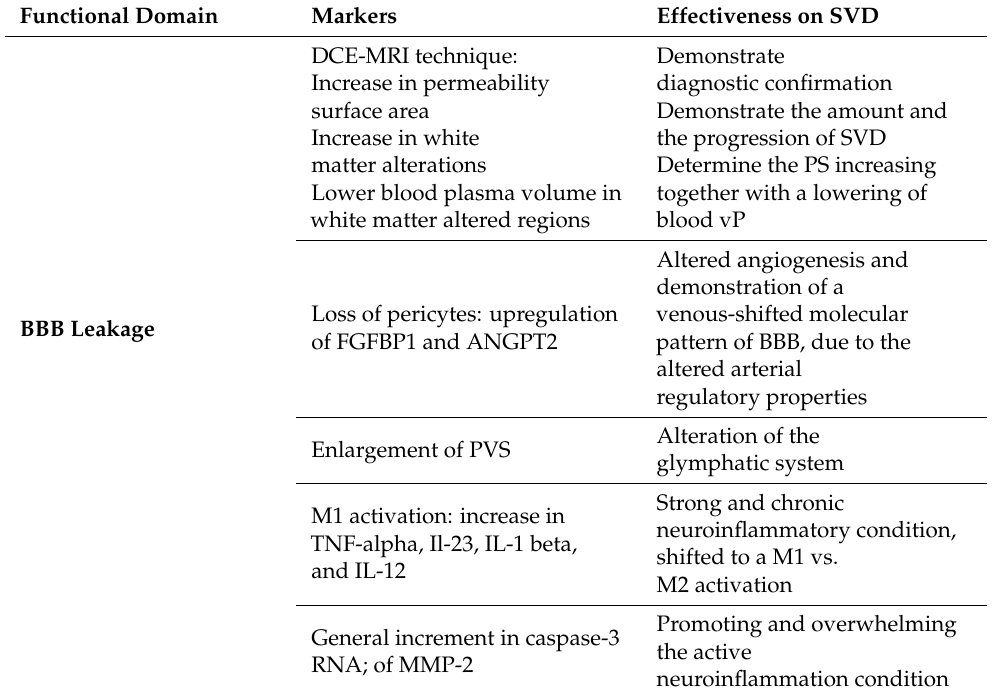
Table 1. Possible hematic or CSF markers of